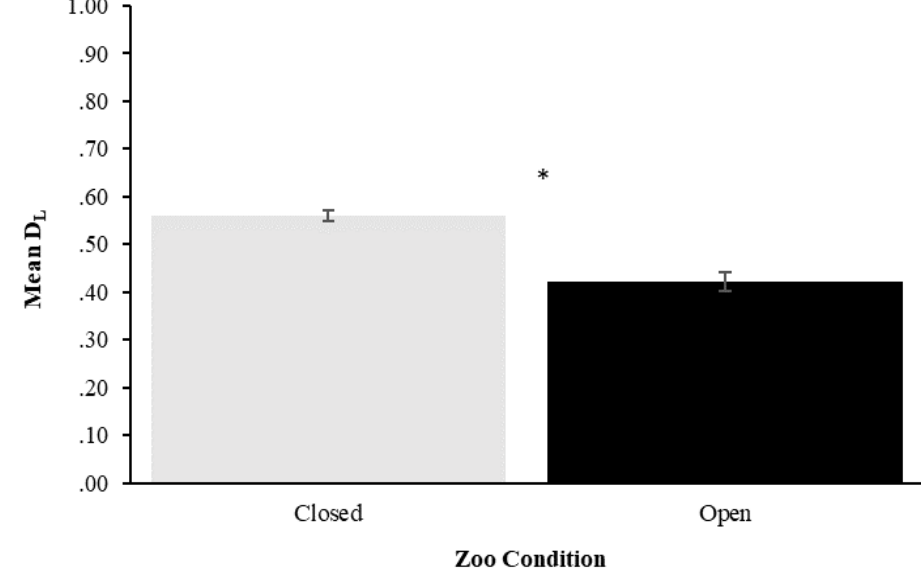
Note . Significant ( p < .05) results are marked with an